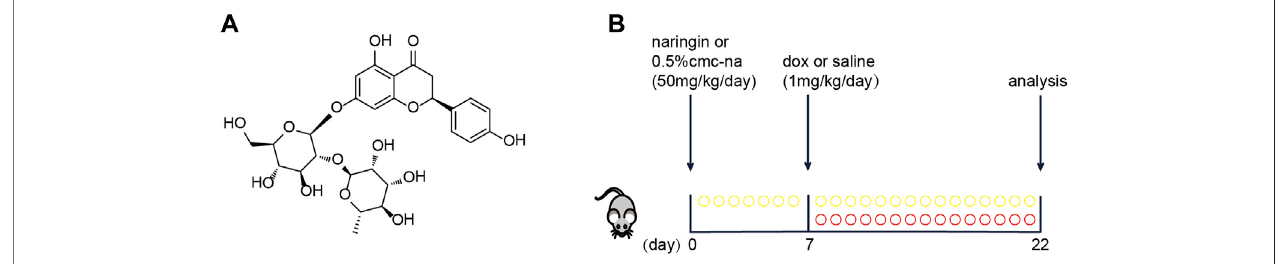
FIGURE 1 | (A) Basic structure of Naringin (NR). (B) Schematic protocol for mice treatments showing models of exposure doxorubicin (DOX), which were performed in mice to test the ef fi cacy of Naringin